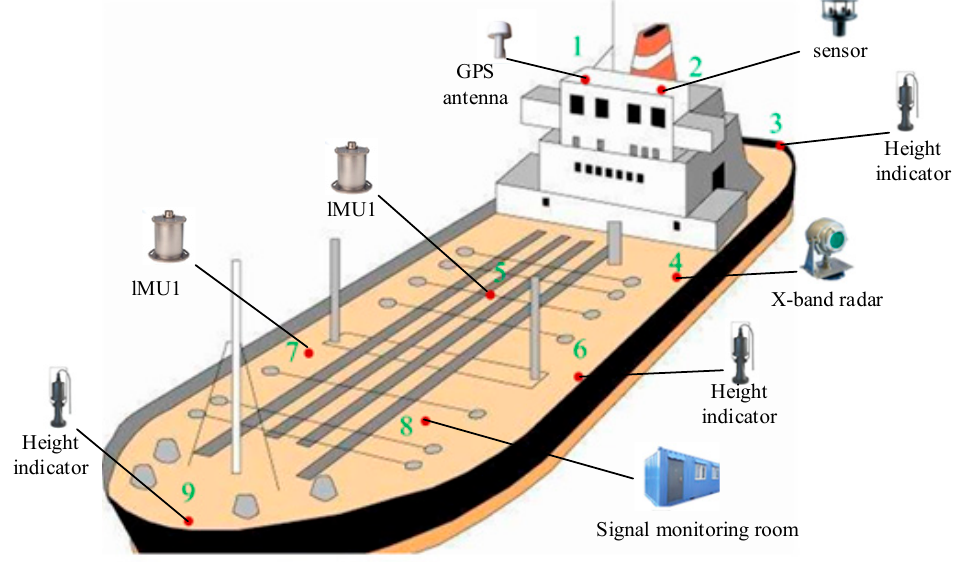
Figure 2. Layout of the environmental monitoring equipment on the pipe-laying vessel.